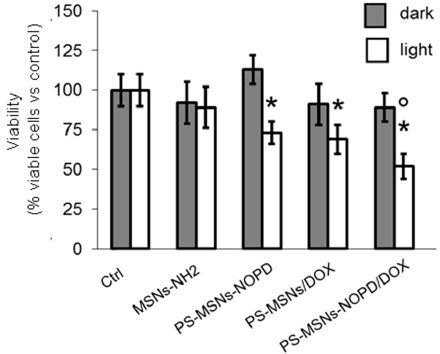
Figure 7. Cell viability of A375 cells, treated a reported in the Materials and Methods Section. Data are presented as means ± SD (n = 3 independent experiments). * p < 0.02: vs. Ctrl, irradiated cells (light); ° p < 0.05: PS-MSNs-NOPD/DOX vs. PS-MSNs-NOPD and PS-MSNs/DOX.